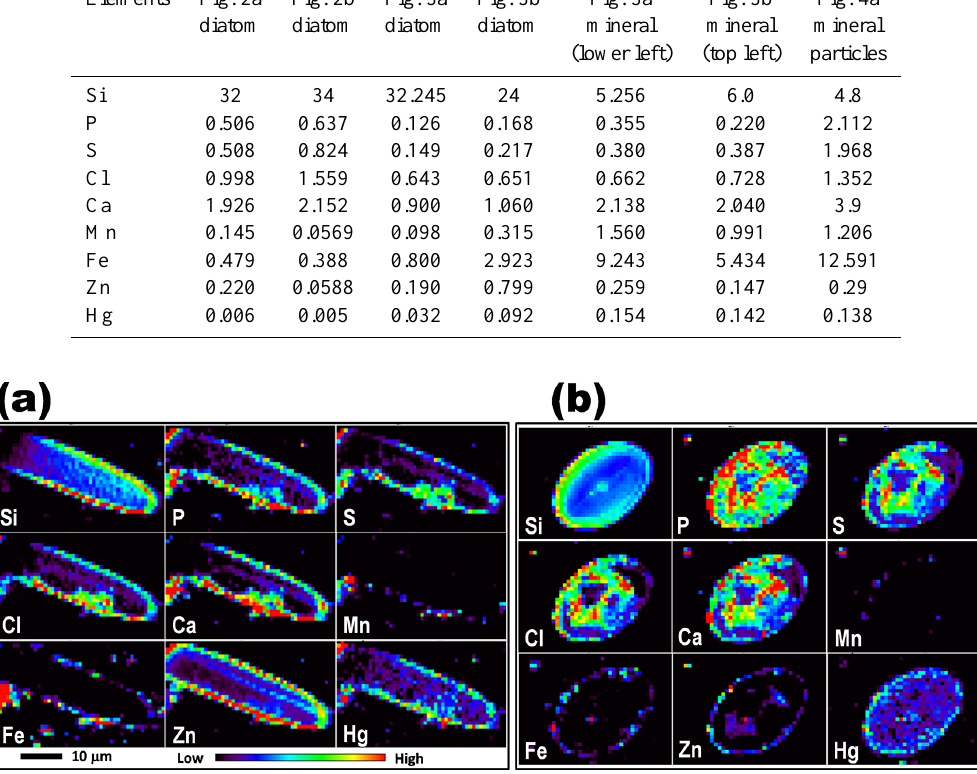
Figure 2. Direct X-ray microprobe fluorescence imaging and elemental analysis of two individual diatoms collected from a Hg-contaminated EFPC creek (EFK23.5) without any treatment. Only selected elements of Hg, Zn, Fe, Mn, Ca, Cl, S, P, and Si were presented due to their relatively high concentrations. The average total Hg content is about 70µgg − 1 particles (dry